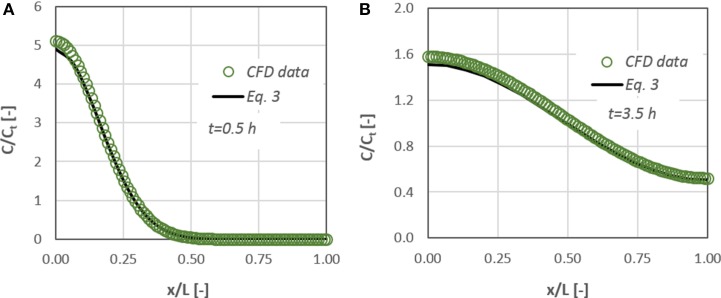
Concentration distribution of a diffusate in a cylindrical μ-tube. Comparison between CFD data and the corresponding results from Equation (3) for: (A)
t = 0.5 h and (B)
t = 3.5 h after the diffusate release.